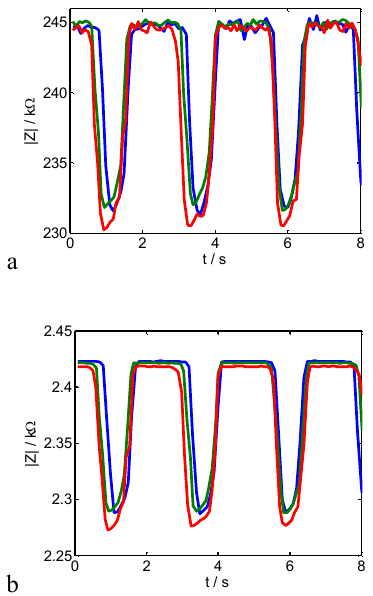
Fig.23: Change in impedance magnitude at 46 kHz (a) and 4.5 MHz (b) of a segmented flow of paraffine oil and KCl – solution in a 0.5 mm tube. The flow was set to about 2 droplets per